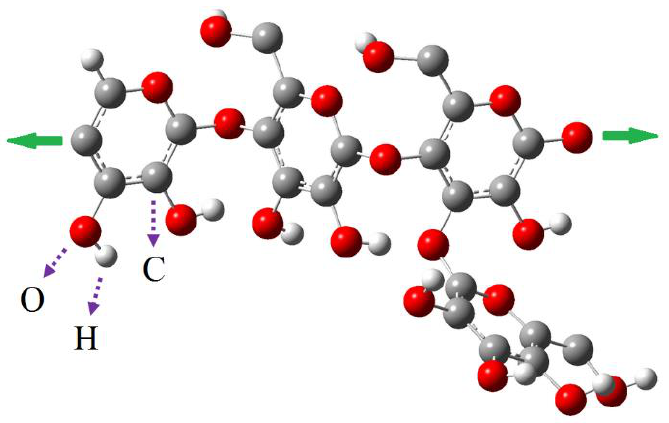
Figure 2. Atomic structure of hemi-cellulose.